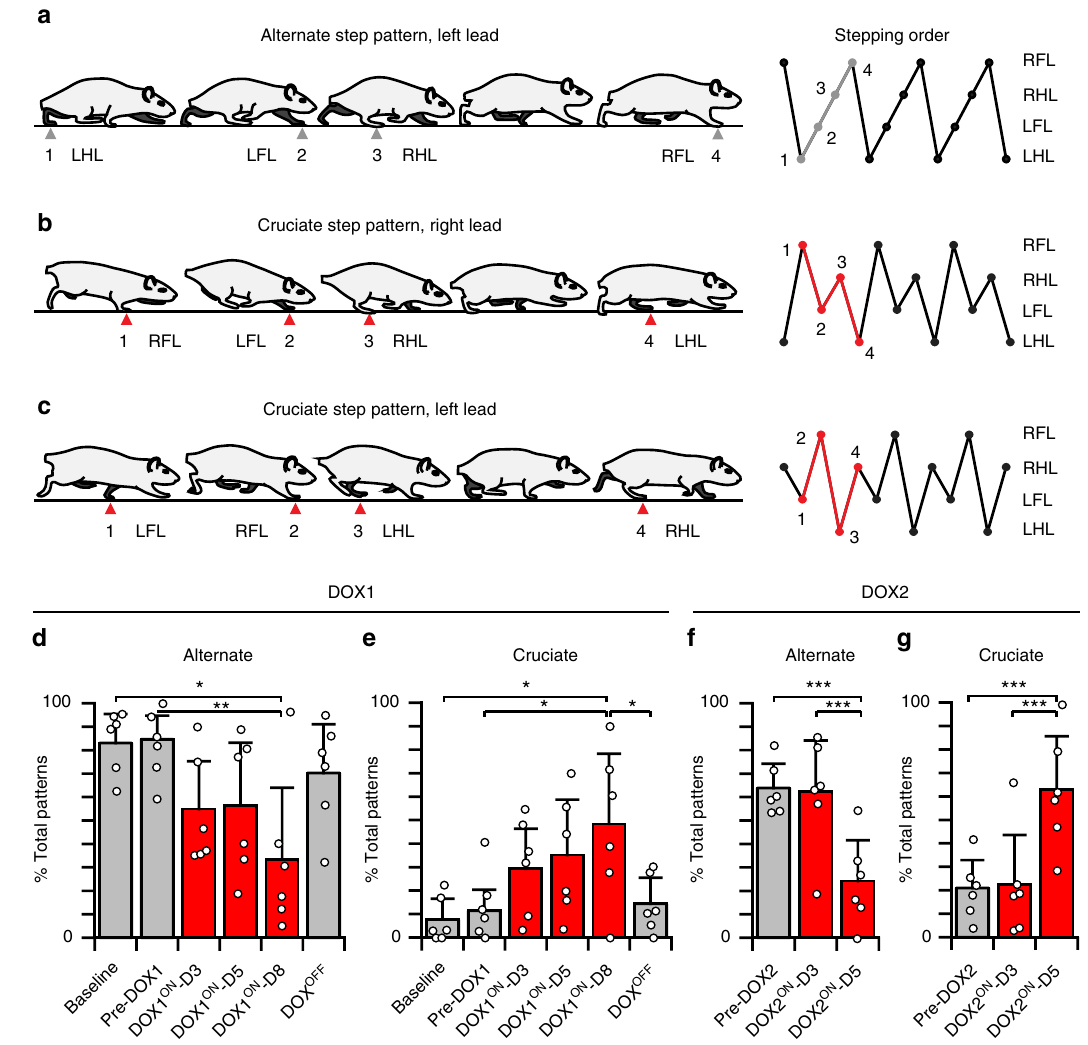
Fig. 3 Silencing L2 – L5 interneurons altered the locomotor step sequence pattern. a – c Schematics of alternate and cruciate step sequence patterns (SSPs) as de fi ned by footfall order (right panels, SSP illustrated as a series of circles interconnected with lines). SSPs are de fi ned by the footfall order (does not measure the duration of swing – stance phases). d The alternate pattern predominates at control time points (Baseline: 83.0 ± 13.5%; Pre-DOX1: 82.3 ± 14.8%). d , e Silencing L2 – L5 interneurons changed the pattern from alternate to cruciate (DOX1 ON -D8: 33.5 ± 30.4% alternate, 48.4 ± 29.8% cruciate as compared to 7.7 ± 8.9% and 11.4 ± 9.0% at Baseline and Pre-DOX1, respectively). f , g This was reversed by DOX removal and replicated 1 month later (circles = individual means; bars = group mean ± S.D.; n = 47 – 66 step sequence patterns/time point; data shown as percentage of total patterns observed) (* p ≤ 0.05; ** p ≤ 0.01; *** p ≤ 0.001, repeated measures analysis of variance (ANOVA) and Tukey's honest signi fi cant difference (HSD) post hoc t -tests). LHL left hindlimb, RHL right hindlimb, LFL left forelimb, RFL right forelimb. d Baseline vs. DOX1 ON -D8: p = 0.014, critical t = 0.41, df = 20; Pre-DOX1 vs. DOX1 ON -D8: p = 0.006; critical t = 0.51, df = 20). e Baseline vs. DOX1 ON -D8: p = 0.016; Pre-DOX1 vs. DOX1 ON -D8: p = 0.032; DOX1 ON -D8 vs. DOX OFF : p = 0.048; each comparison with a critical t = 0.33, df = 25. f Pre-DOX2 & DOX2 ON -D3 vs. DOX2 ON -D5: p < 0.001; each with critical t = 0.2, df = 10. g Pre-DOX2 & DOX2 ON -D3 vs. DOX2 ON -D5: p < 0.001; each with critical t = 0.3, df = 10. Illustrations by A.